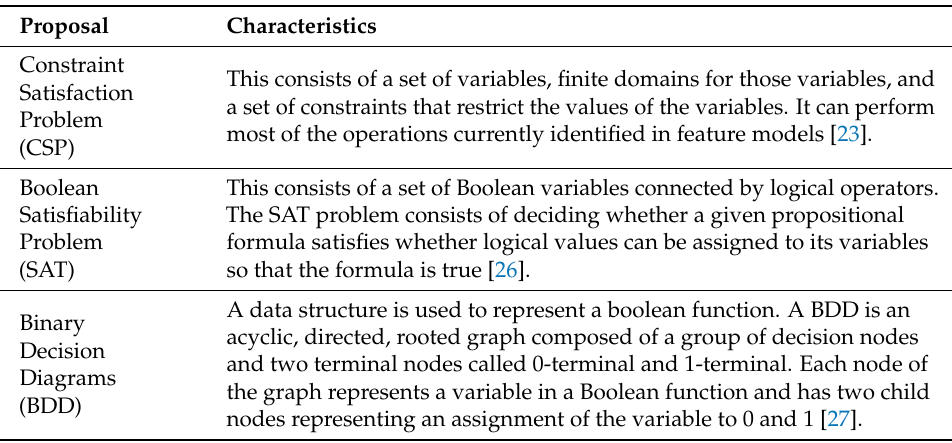
Table 1. Proposals to extract information from